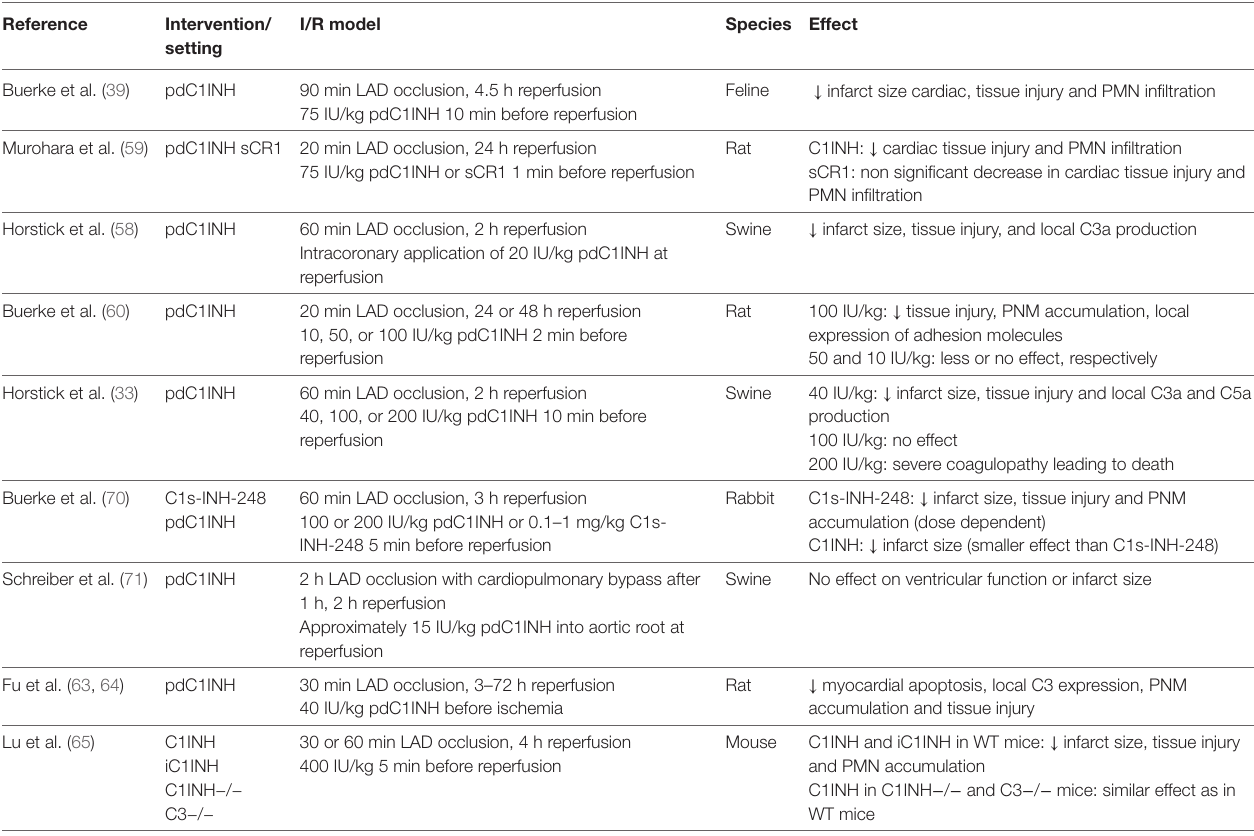
TABLe 3 | Effect of C1INH in murine models of myocardial I/R injury. Reference